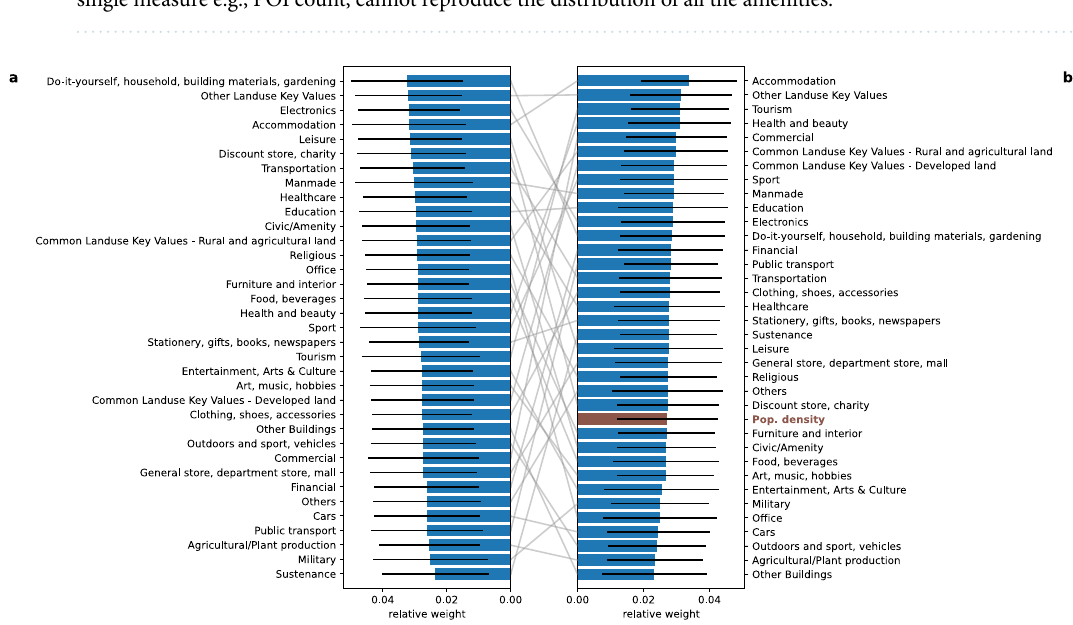
Figure 5. Feature importance of the two best performing models with amenity features. ( a ) Logistic z- score normalization, amenities only ( b ) Logistic z- score normalization, population density with amenities. The most important features are not directly related to job opportunities which suggests people move not just because of job opportunities. Population feature importance is not ranked highly, even omitted in the best performing model which suggests amenities already include information derived from